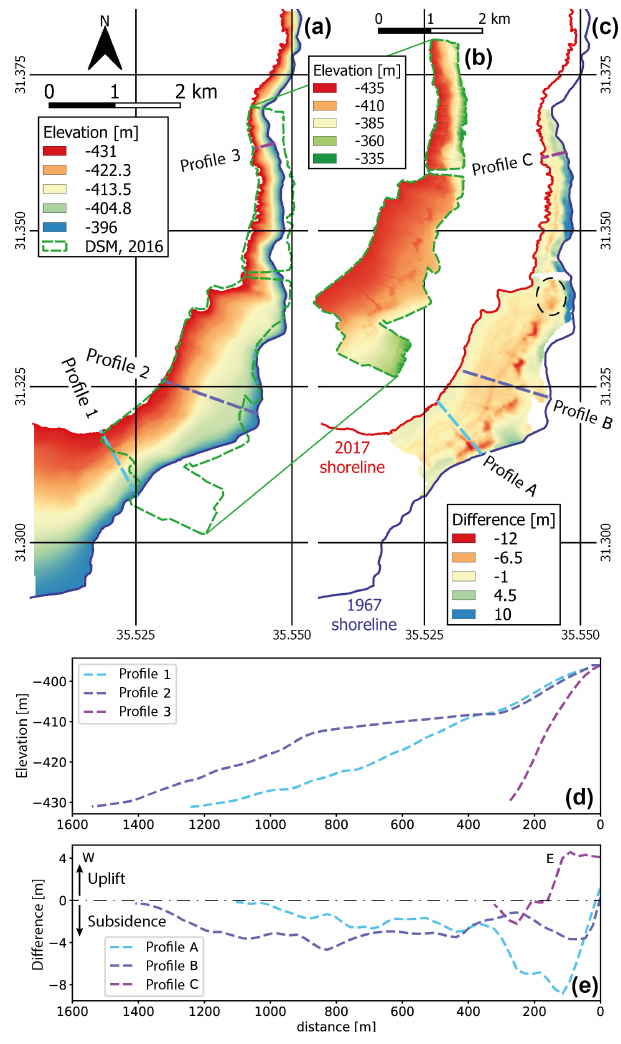
Figure 3. (a) Bathymetric contour map of the relief of the former lakebed (top left), with a zoomed-in view (b) of the 2016 DSM re- lief and elevation profiles 1–3 (as in Fig. 3) plotted second from bottom. (c) Map of elevation difference between the former lakebed bathymetry and the 2016 topography. (d) Plot of elevation vs. dis- tance along profiles 1–3 as labelled in (a) . (e) Plot of elevation dif- ference vs. distance along profiles A–C as labelled in (c) . Areas of significant subsidence are identifiable by the large negative differ- ence (see 0–300m along profile A). There is subsidence of between 0 and 6m on the kilometre scale in the southern part of the study area (profiles A and B), with subsidence of 0–3m on a smaller scale in the northern part of the study area (profile C). The dashed black ellipse indicates a zone of developing uvala-like subsidence referred to in Sect.